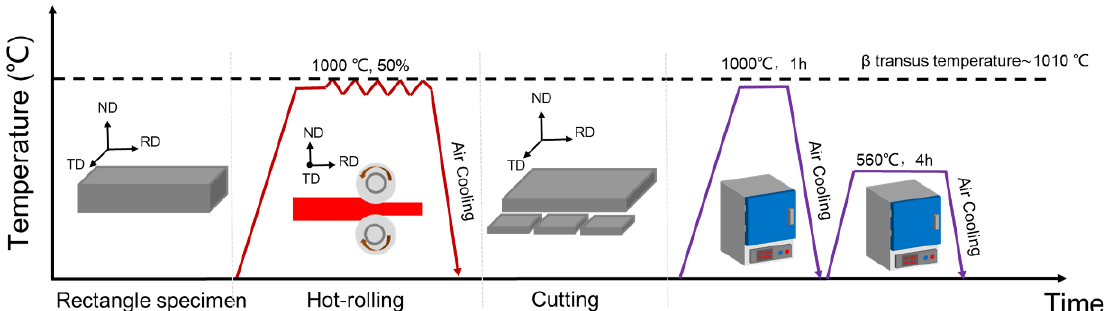
Figure 1. Schematic illustration of sample preparation for hot rolling (HR) and solution-aging treatment (STA).